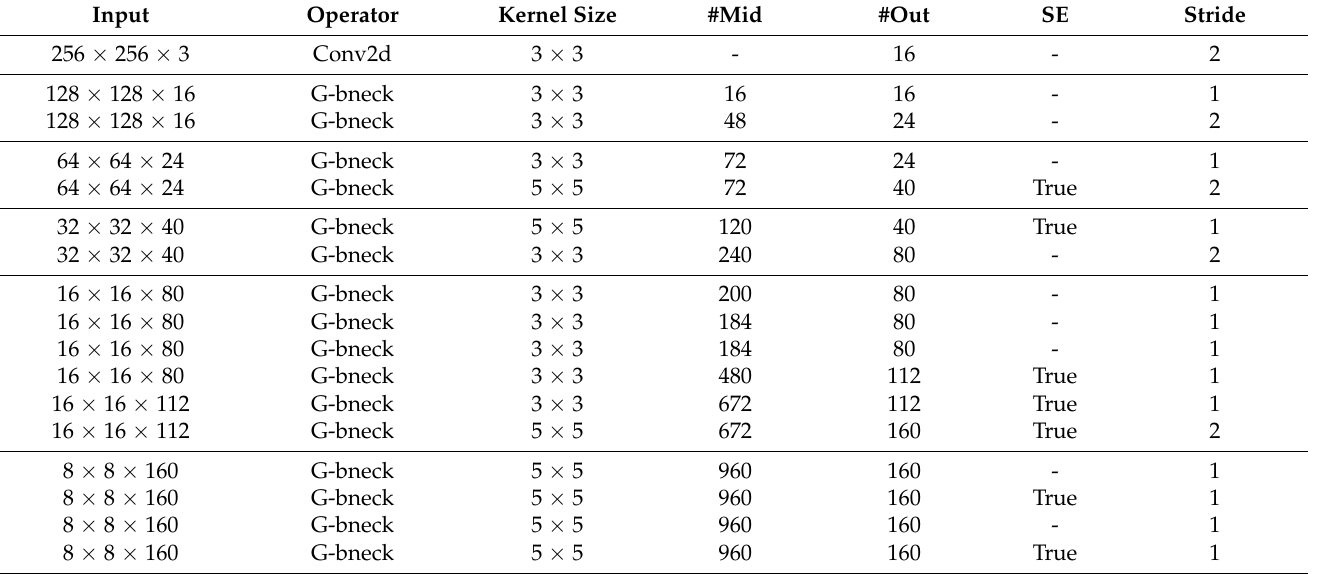
Table 1. Details of GhostNet used. The kernel size is applied to all convolutions in the corresponding G-bneck. #mid represents the number of extended channels in the Ghost module. #out represents the number of output channels. SE stands for a plug-and-play attention module.